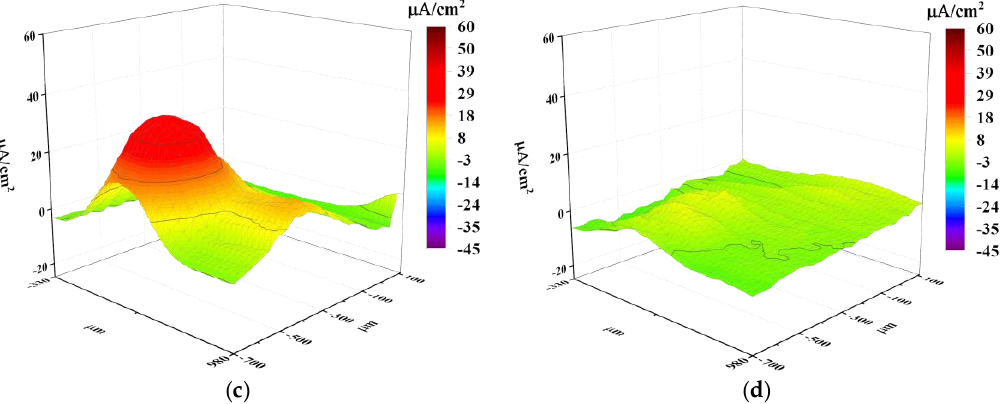
Figure 9. Ionic current maps of the experimental steel during immersion in the solution during the 4-h SVET test: ( a ) 5 min; ( b ) 1 h; ( c ) 2 h; and ( d ) 4 h. Test area size: ~1 mm 2 .